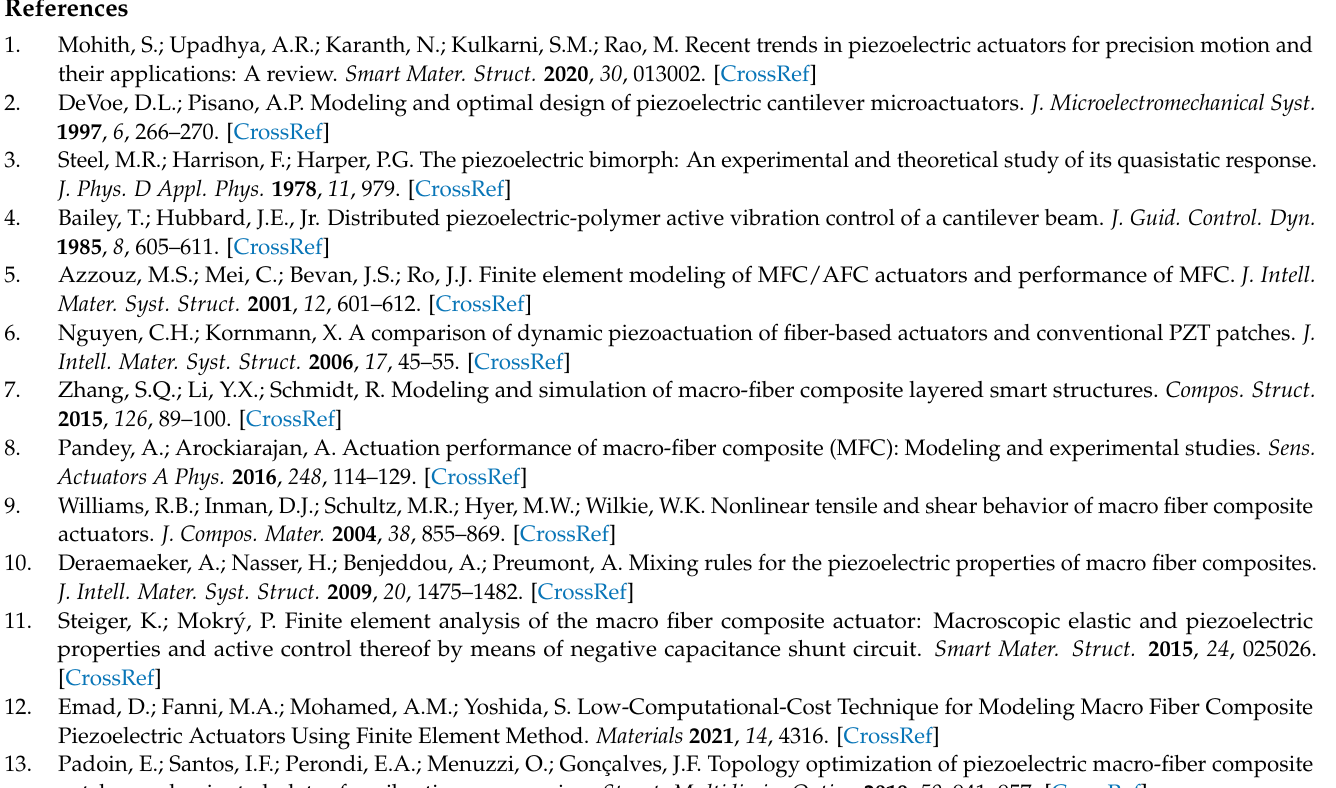
Figure A1. Control system with Kalman filter for a piezoelectric beam